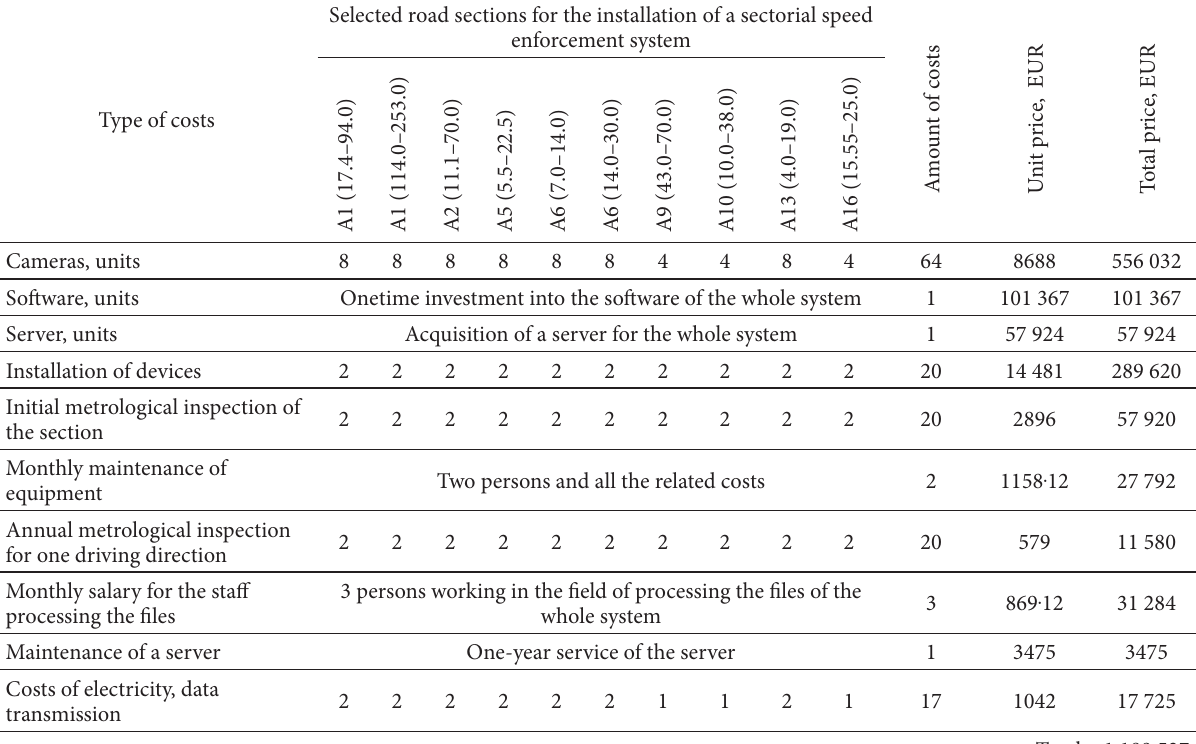
Table 4. Investment demand for the installation of a sectorial speed enforcement system in the initial stage